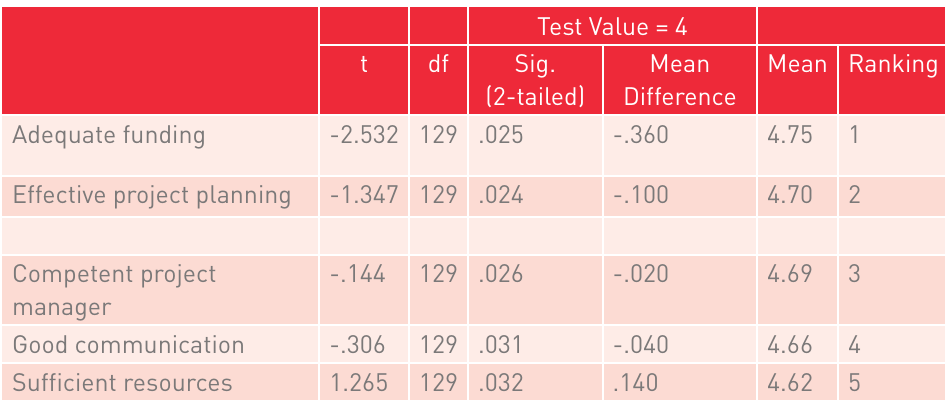
Descriptive statistics and t- Test